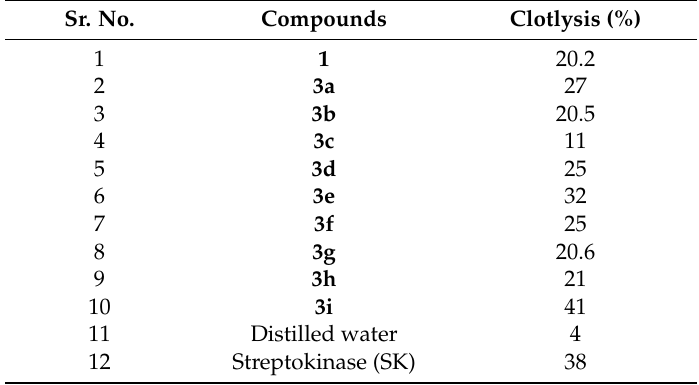
Table 2. In vitro clot lysis effect of synthetic compounds on human blood. Sr. No.